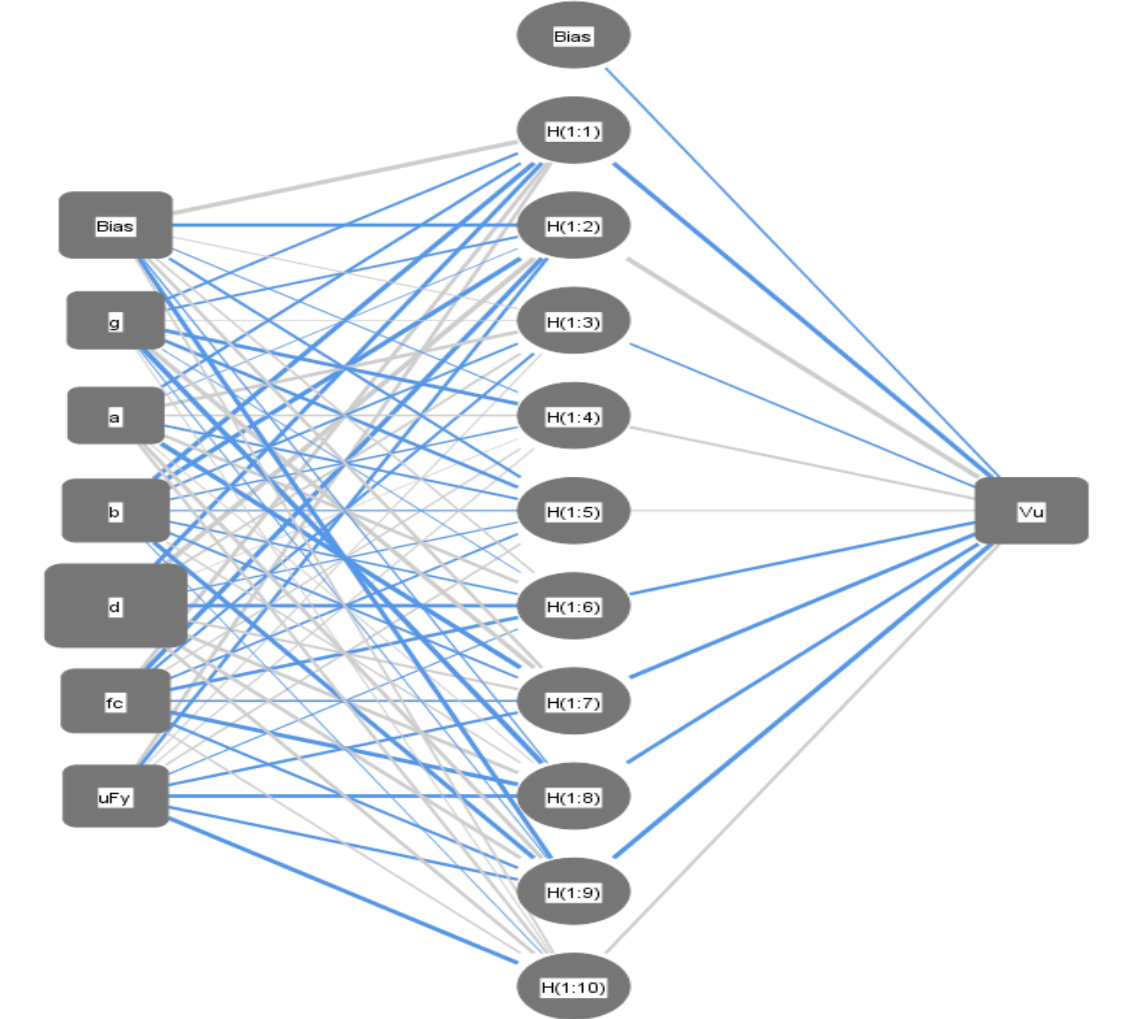
Figure 6. Layout for the developed ANN.